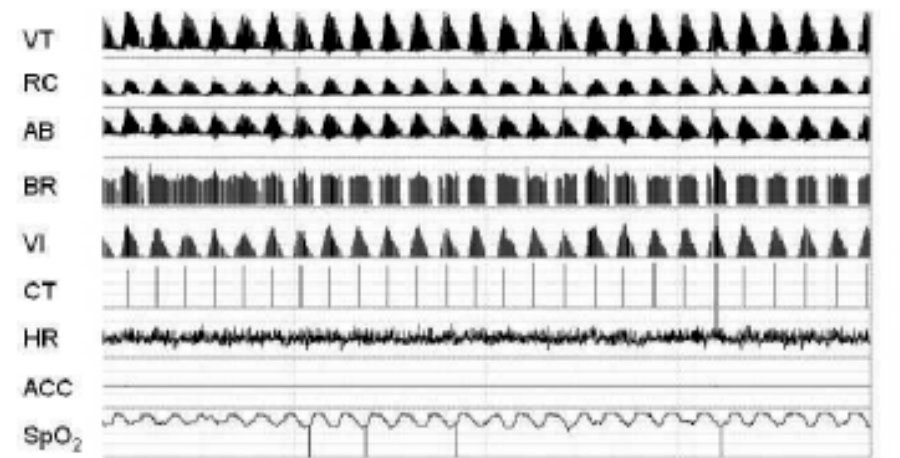
two- to threefold increase in mortality sparked the hope that treatment of CSR would decrease mor- tality, although other reports questioned an inde- pendent association of CSR and mortality in heart failure [11].